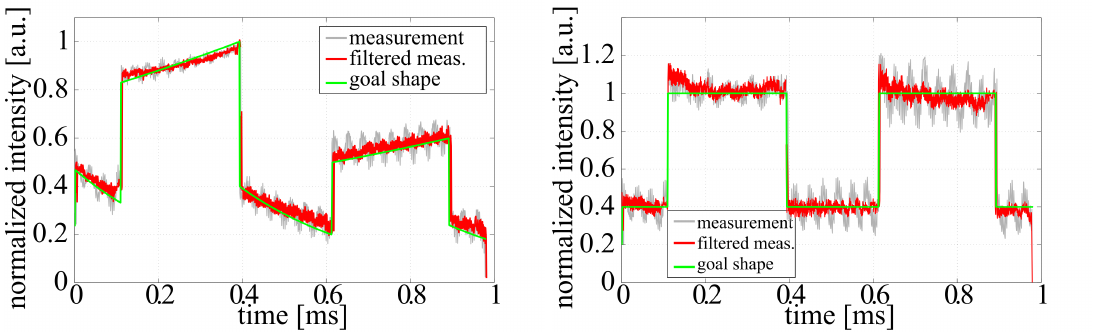
Figure 8. ( Left ): input pulse train to achieve an output with alternating amplitude; ( right ): resulting output pulse train after